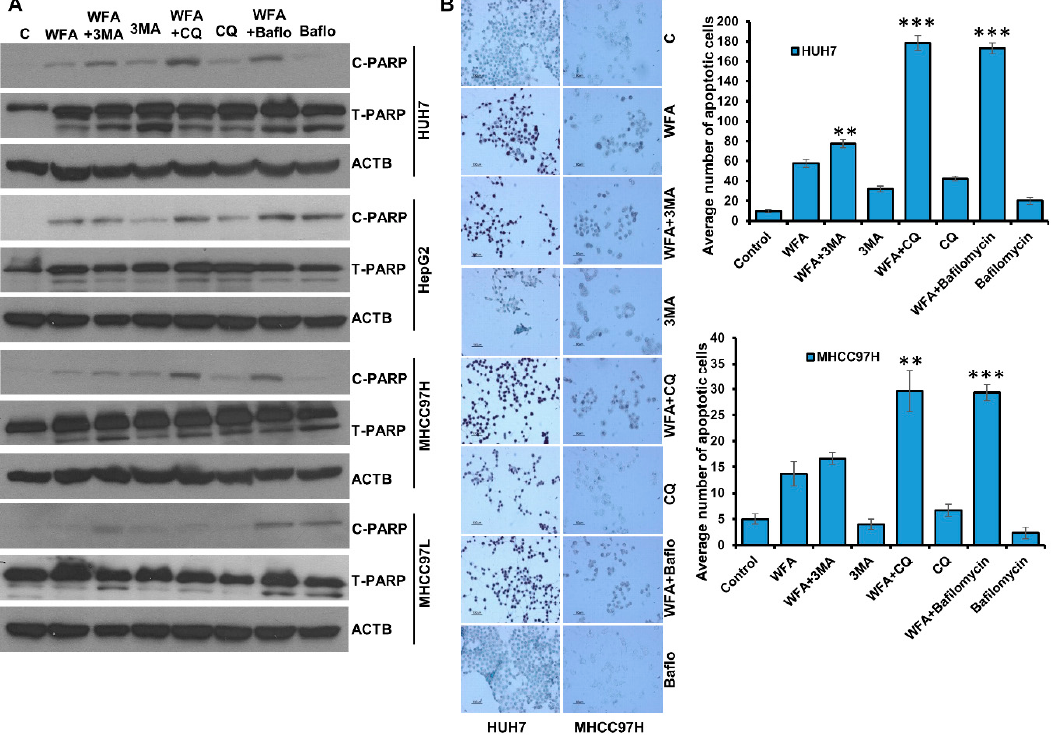
Figure 8. Combined treatment with Withaferin A and autophagic inhibitors induces apoptosis in HCC cells. ( A ) HCC cells were treated with 5 µ M WFA alone and in combination of 4 mM 3MA, 25 µ M CQ and 200 nM bafilomycin, respectively, total cellular lysates were prepared and subjected to western blot analysis to examine the expression level of Cleaved-PARP (C-PARP) and Total-PARP (T-PARP), respectively. ACTB served as the loading control. ( B ) Huh7 and MHCC97H were treated with 5 µ M WFA alone or co-treated with 4 mM 3MA, 25 µ M CQ and 200 nM bafilomycin, respectively, and subjected to TUNNEL assay following the manufacturer’s protocol. Images were captured microscopically at 100 × (Huh7) and 50 × (MHCC97H) magnification. Bar graphs show number of apoptotic cells. ** p < 0.01, compared with WFA; *** p < 0.001, compared with WFA, Scale bar, 100 µm.